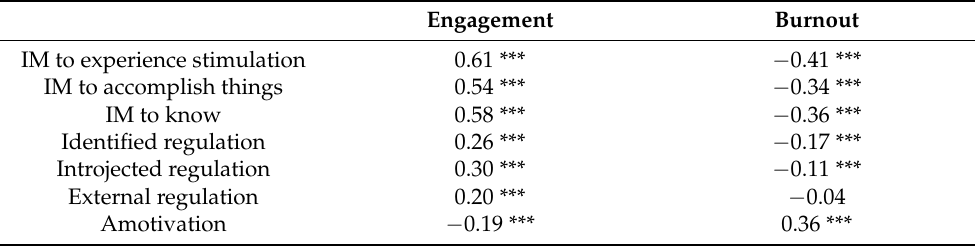
Table 2. Relationship between motivation levels and engagement and burnout.